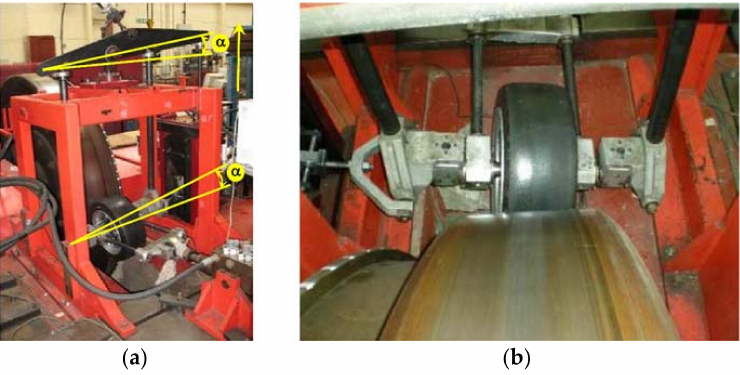
Figure 3. ( a ) Indoor tire test rig setup; ( b ) Tire working under cornering